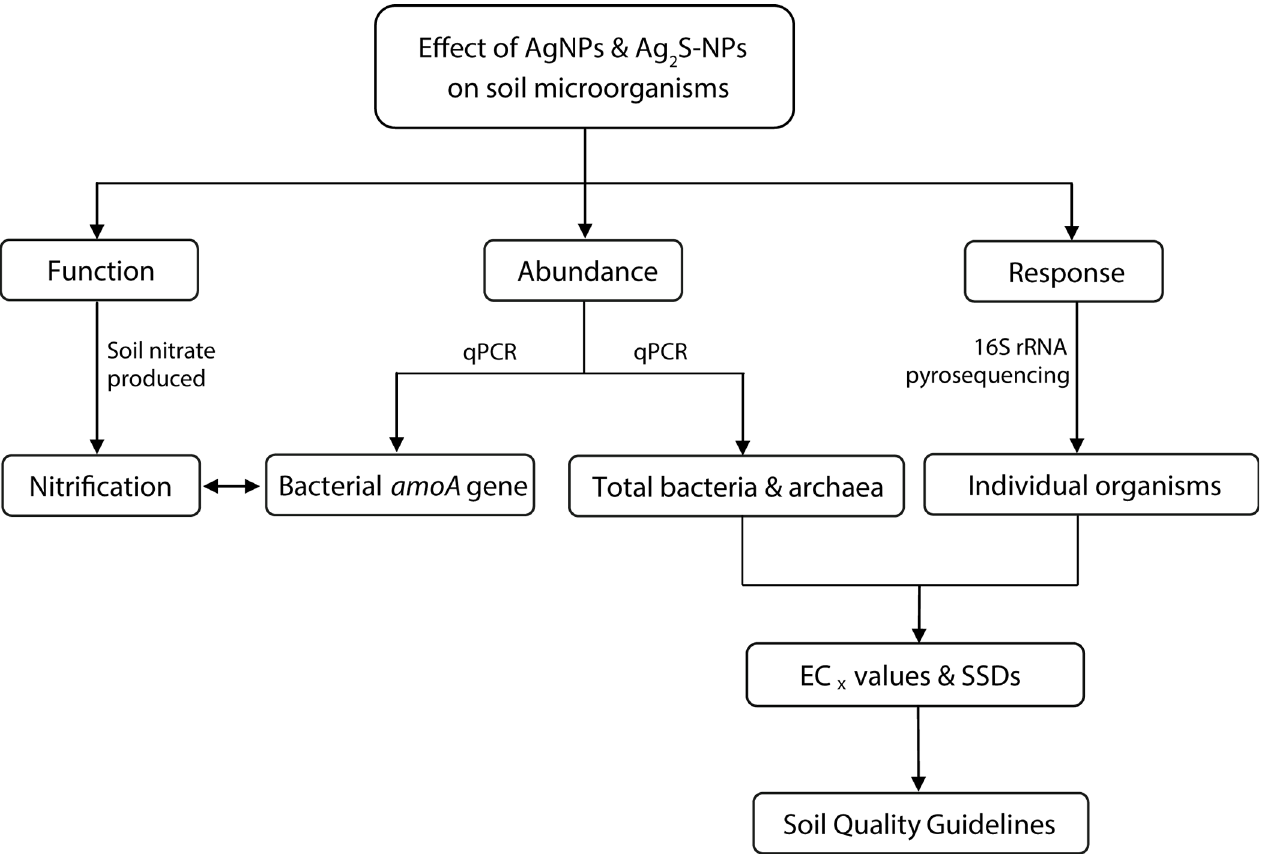
Fig 1. Schematic overview of the study. The techniques that were used to investigate each parameter are shown on the